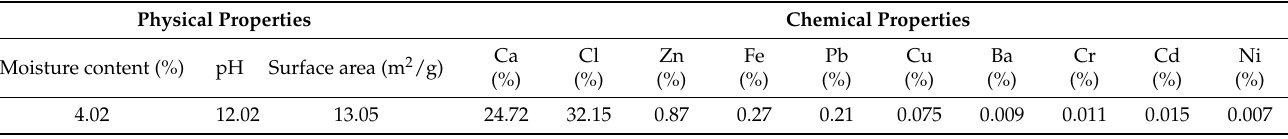
Table 1. Physical and chemical properties of raw MSWI fly